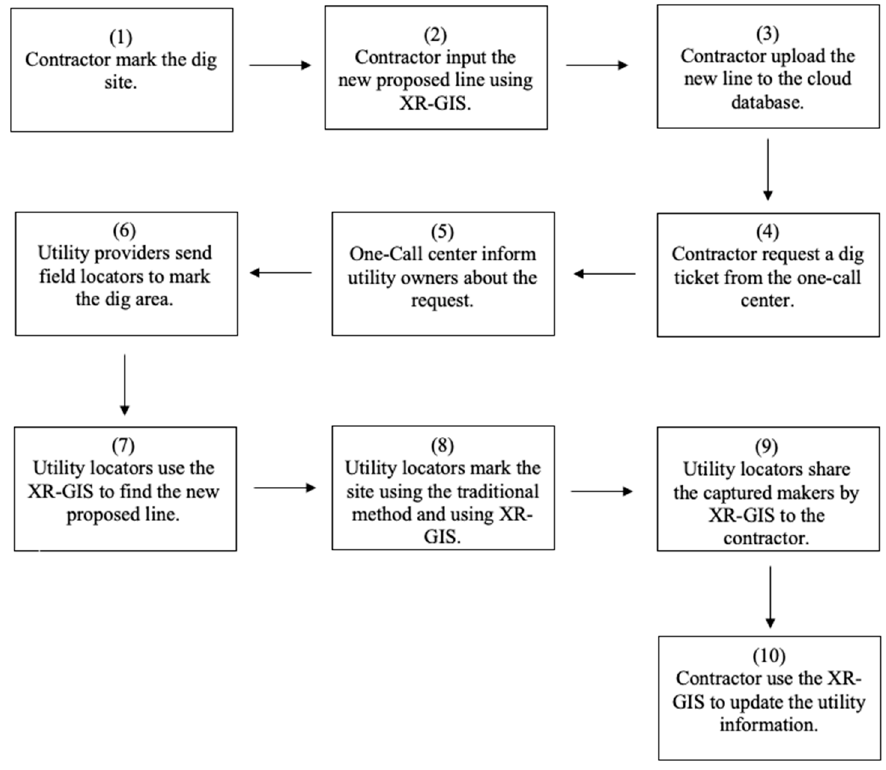
Figure 7. XR-GIS framework for underground construction sites.